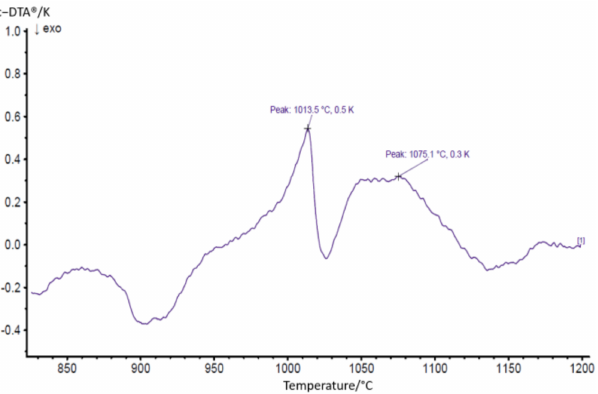
Figure 2. DTA curve highlighting the solidus and liquidus temperature of the NiCrBSi